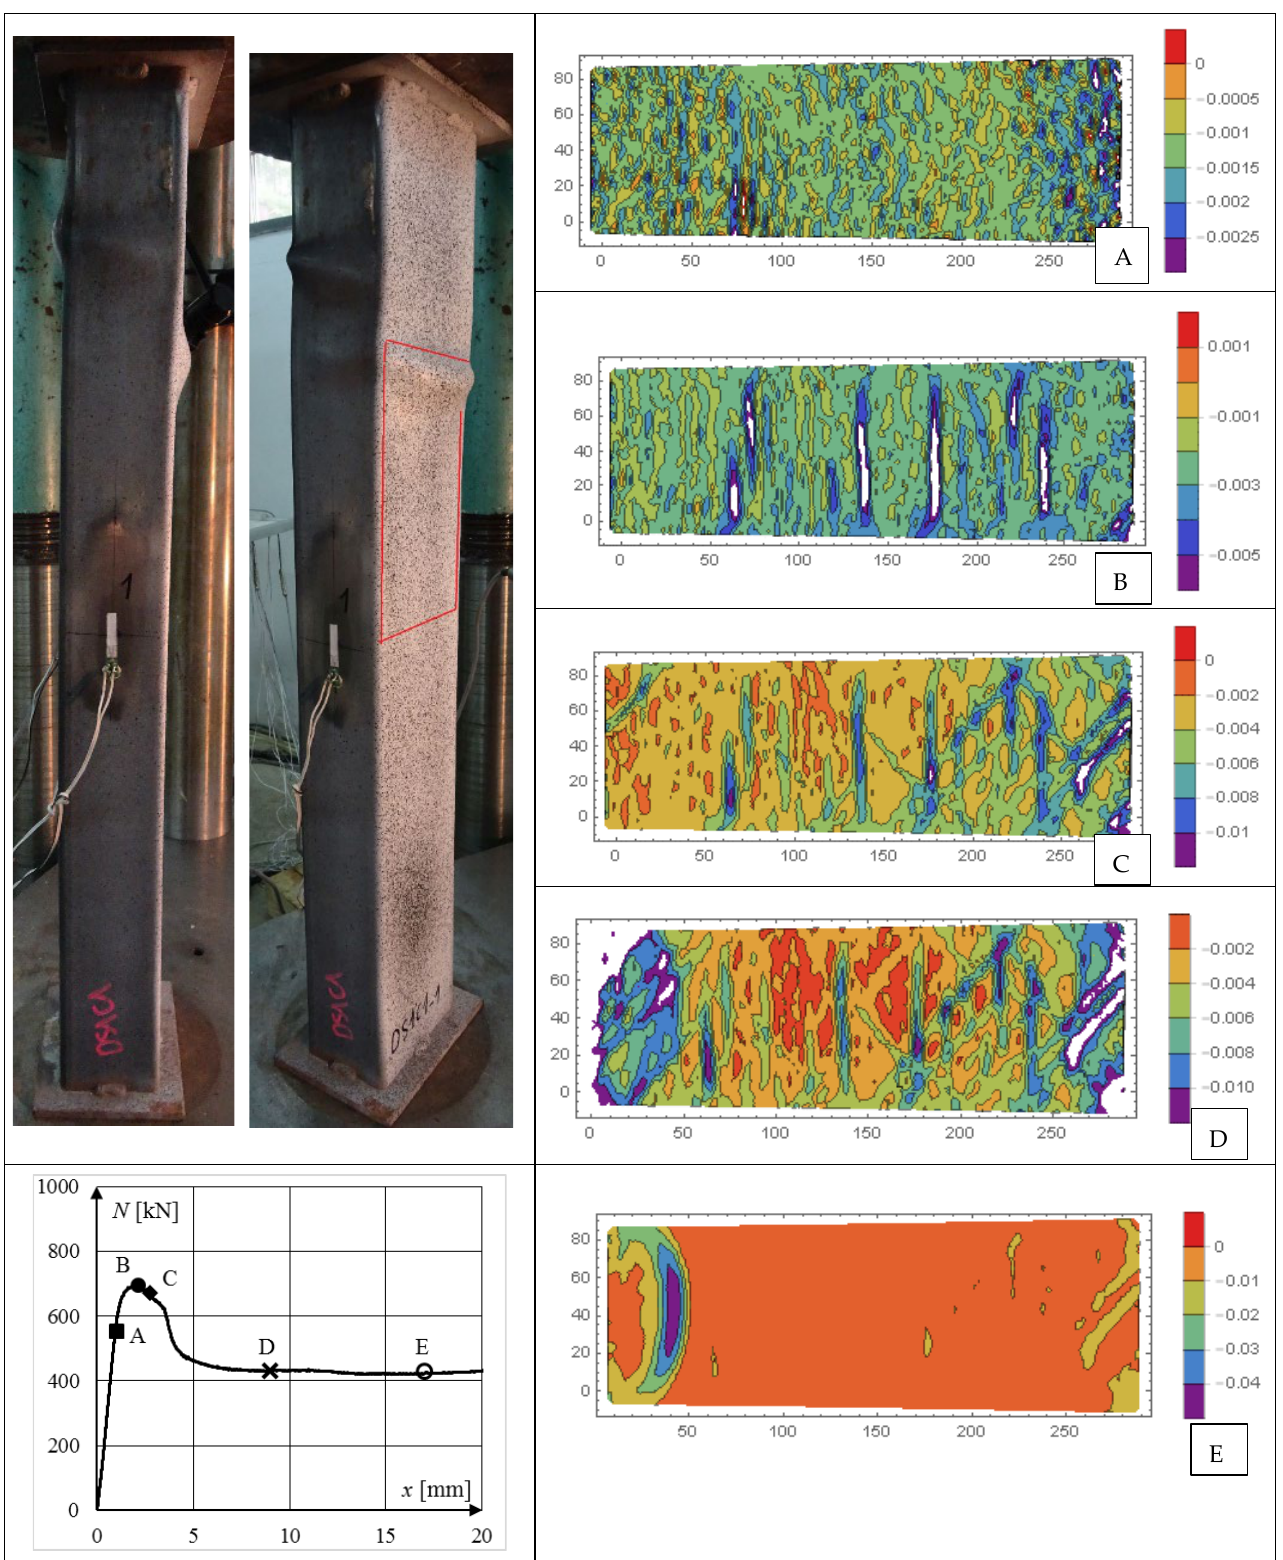
Figure 20. Evolution of strains ε xx in column DS1C1_1, steel S235, weaker concrete, ξ = 1.16. Points ( A , B ) indicate strains before reaching the ultimate load and when the maximum force was reached, respectively. Points ( C – E ) mark selected places in the post-peak part of the equilibrium path.